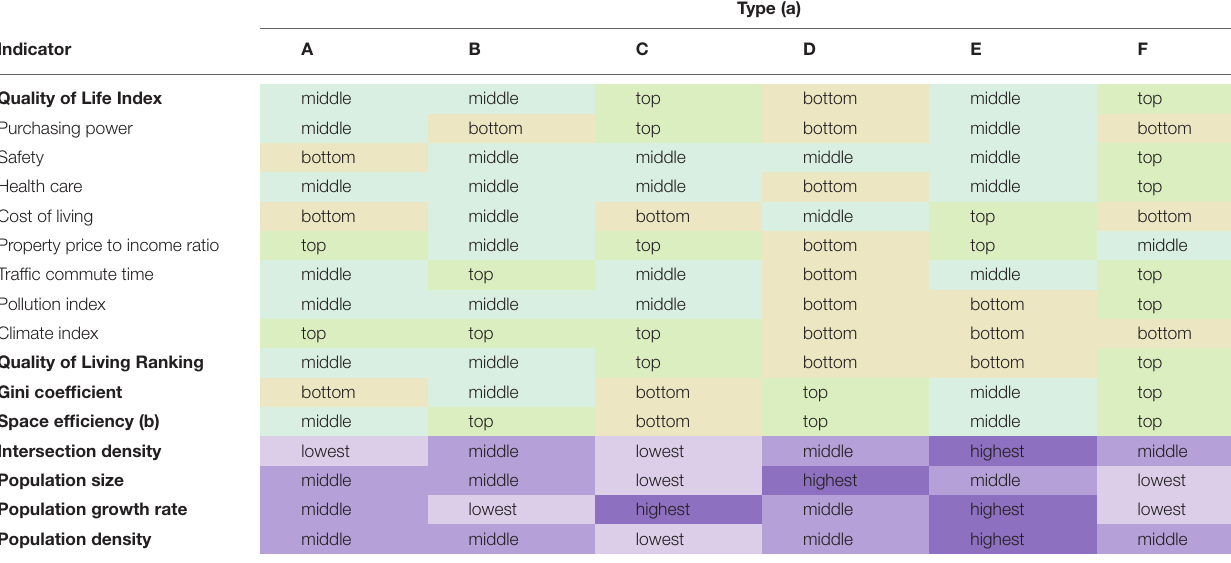
TABLE 4 | Livability, sustainability, and spatial form statistics for each city